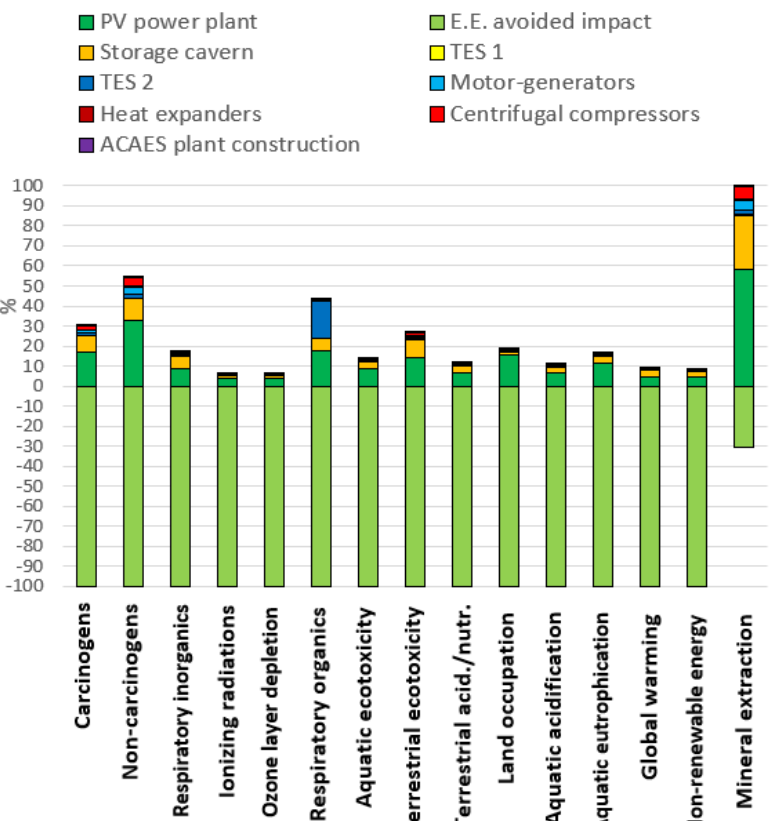
Figure 9. Midpoint indicators for configuration C3 with underground air storage.